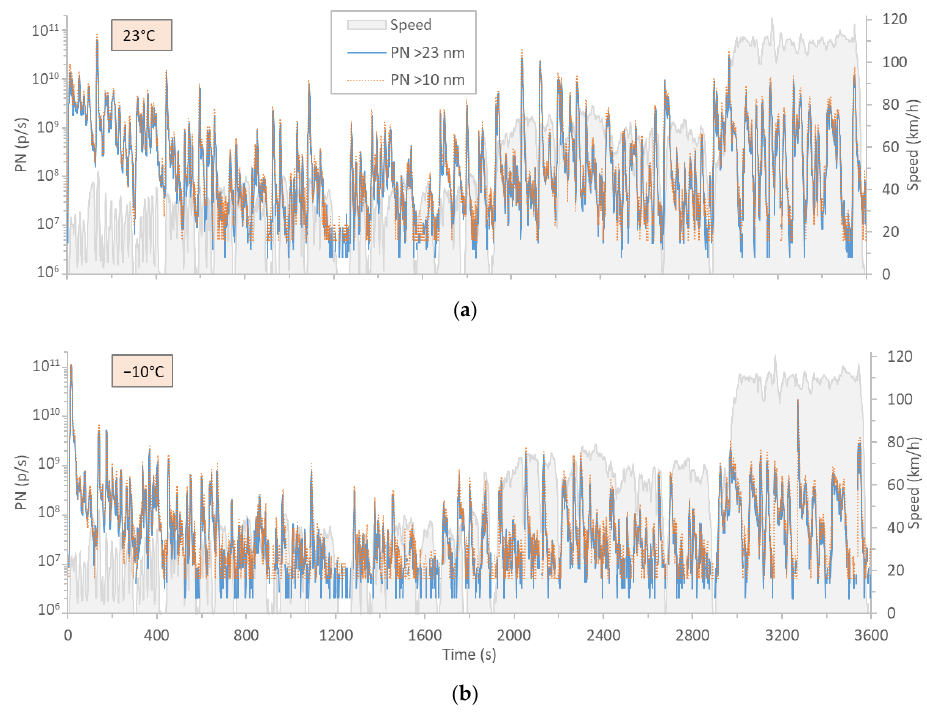
Figure 2. Short RDE driven on the chassis dynamometer: ( a ) Particle number (PN) > 23 (blue line) and >10 nm (orange line) at 23 °C, and; ( b ) −10 °C. The speed profile is given in grey background.